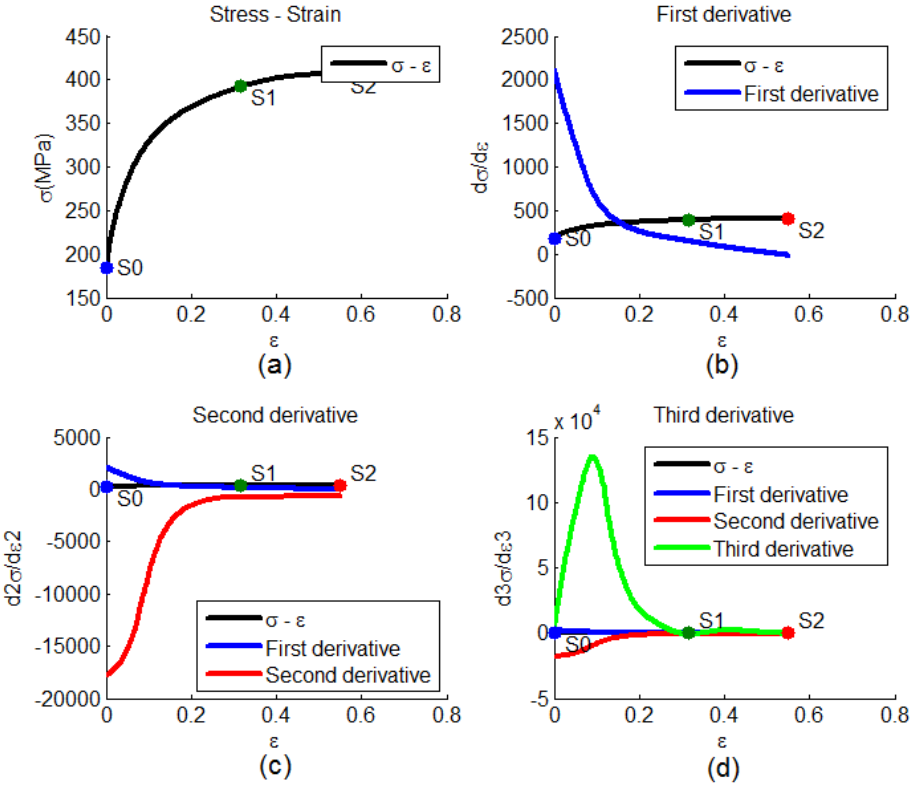
Figure 2. Plot with the stress-strain curve ( a ) and its corresponding curves for the first ( b ), the second ( c ) and the third derivatives ( d ).